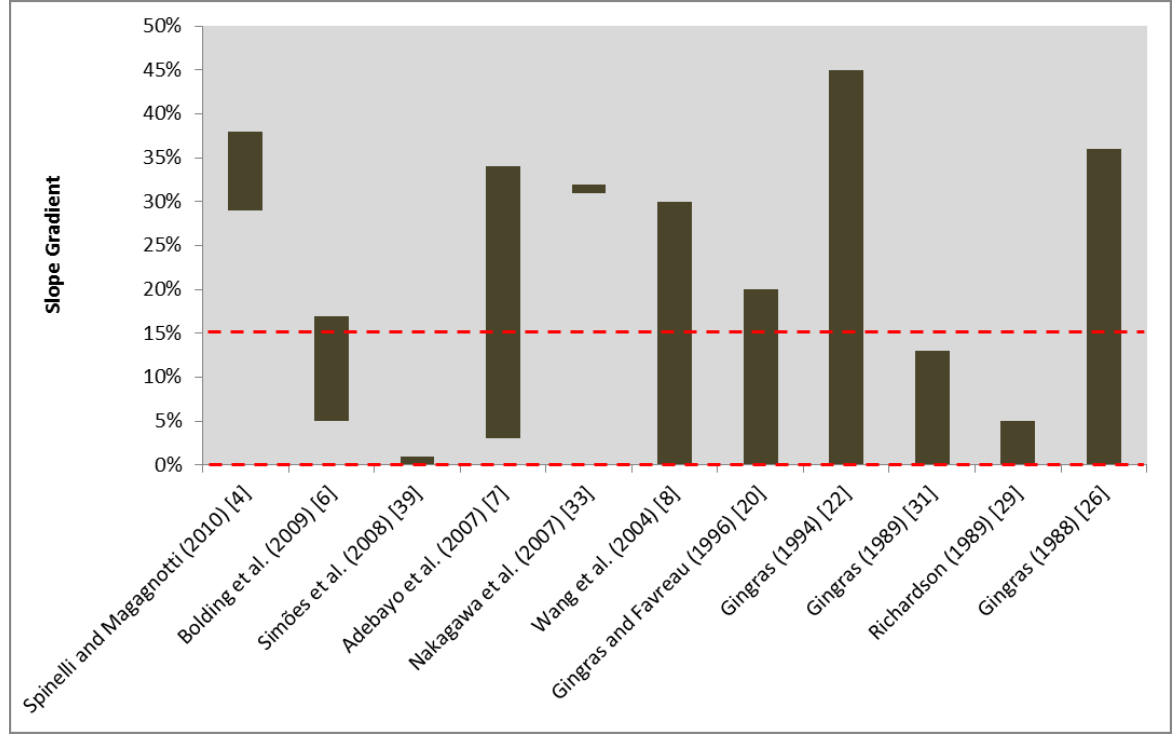
Figure 4. Summary of slope gradients of harvesting equipment productivity studies. Dashed red lines represent the upper and lower slope limit of forestland commonly harvested by whole-tree and cut-to-length harvesting systems in